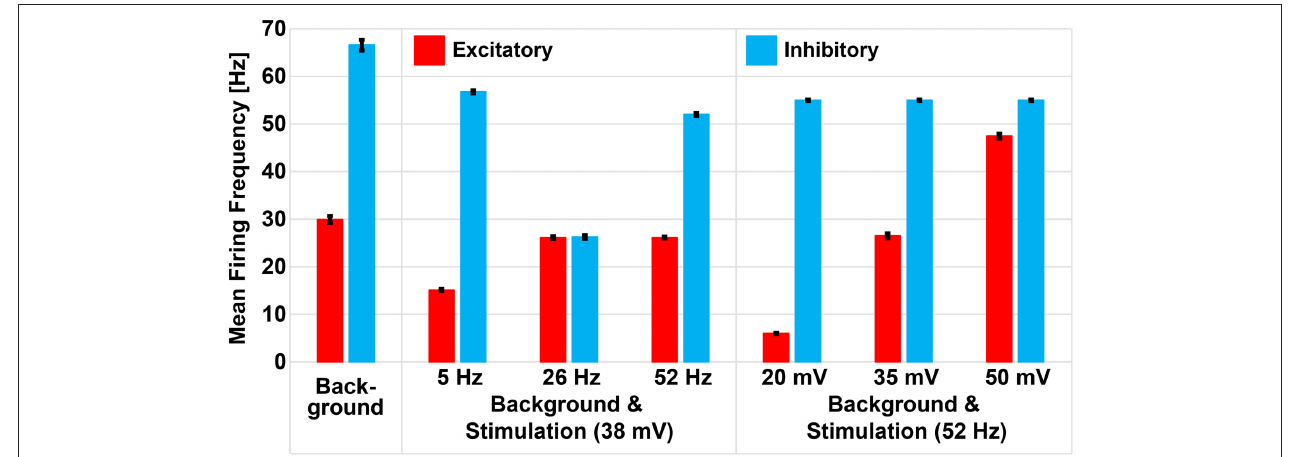
FIGURE 8 | Repetitive stimulation changes mean firing rate of excitatory and inhibitory neurons in presence of background activity . Excitatory and inhibitory neurons of the small-world network had mean firing frequencies of 29.94 Hz ( ± 0.7 Hz) and 66.56 Hz ( ± 1.12 Hz), respectively, as a result of excitation received from the excitatory background population. Sinusoidal stimulation at 38 mV selectively modulated the mean firing rate of excitatory and inhibitory neurons to 15.12 Hz ( ± 0.2 Hz) and 56.75 Hz ( ± 0.32 Hz) during 5 Hz, 26.12 Hz ( ± 0.1 Hz) and 26.24 Hz ( ± 0.1 Hz) during 26 Hz, and 26.12 Hz ( ± 0.14 Hz) and 51.99 Hz ( ± 0.1 Hz) during 52 Hz stimulation. However, fixing the stimulation frequency at 52 Hz and varying the amplitudes, we noticed gradual enhancement of excitatory neuron only (i.e., from 6.02 ± 0.12 Hz to 26.47 ± 0.51 Hz to 47.47 ± 0.52 Hz) while the inhibitory neuron remained unchanged ( 54.97 ± 0.16 Hz).